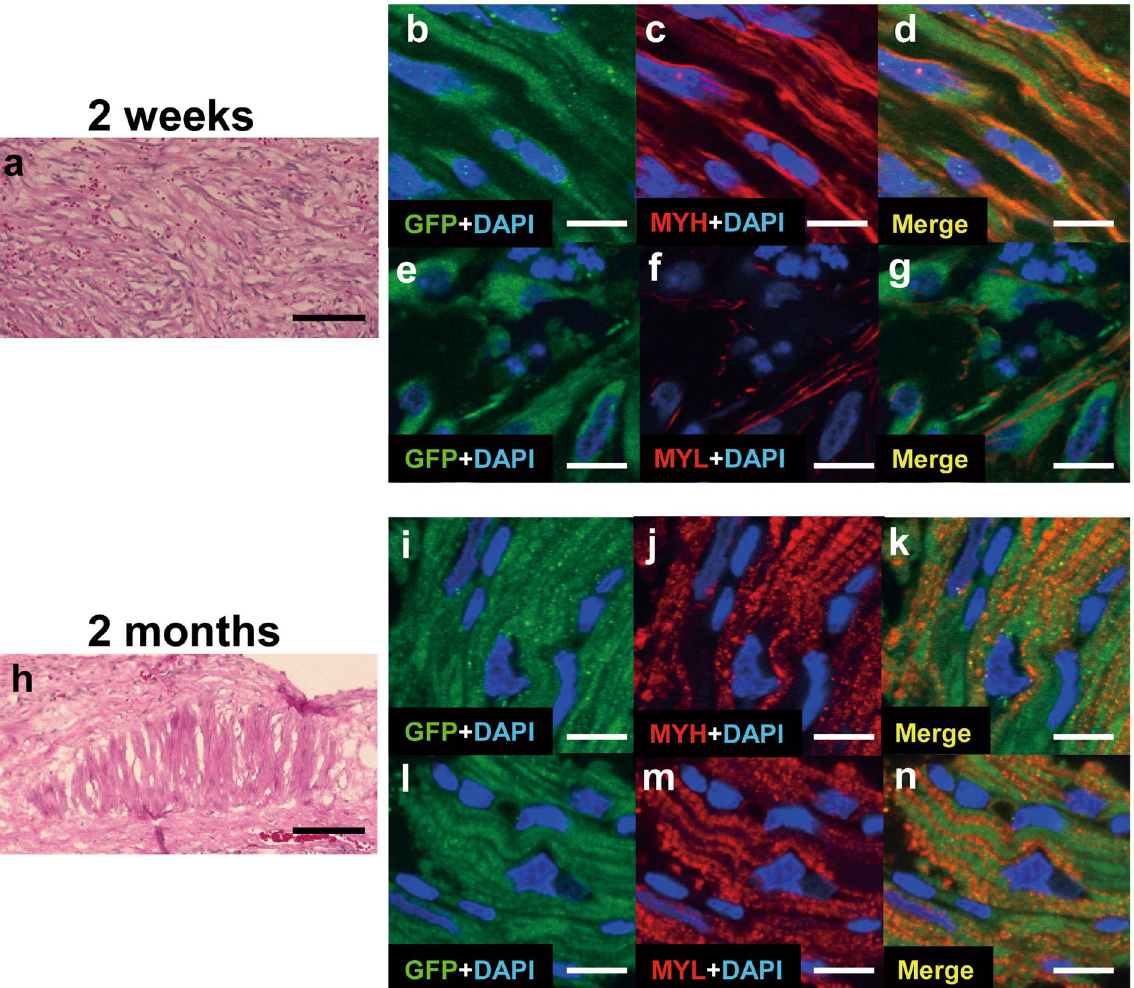
Figure 8. The EGFP labeled hiPS-CMs after transplantation with the omentum. ( a – g ) Detection of EGFP- labeled hiPS-CMs 2 weeks after transplantation; representative photomicrographs showing HE stain ( a ), GFP in green ( b , e ), myosin heavy chain (MYH) and myosin light chain-2 (MYL) in red ( c , f ). ( h – n ) Detection of EGFP- labeled hiPS-CMs 2 months after transplantation; representative photomicrographs showing HE stain ( h ), GFP in green ( i , l ), and MYH and MYL in red ( j , m ). The nuclei were stained with DAPI in blue ( b – g , i – n ). Merged images are shown in ( d , g , k , n ). Bar = 100 μ m in ( a , h ), 10 μ m in ( b – g , i – n